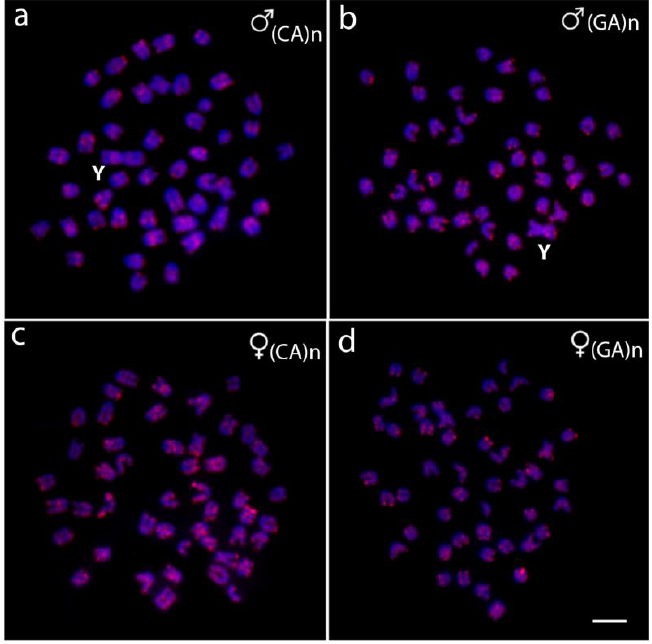
Figure 2. Mitotic chromosome spreads of O . punctatus males ( a , b ) and females ( c , d ) hybridized with the microsatellite probes (CA) 15 ( a , c ) and (GA) 15 ( b , d ). Chromosomes were counterstained with DAPI (blue). Scale bar = 5 μm.